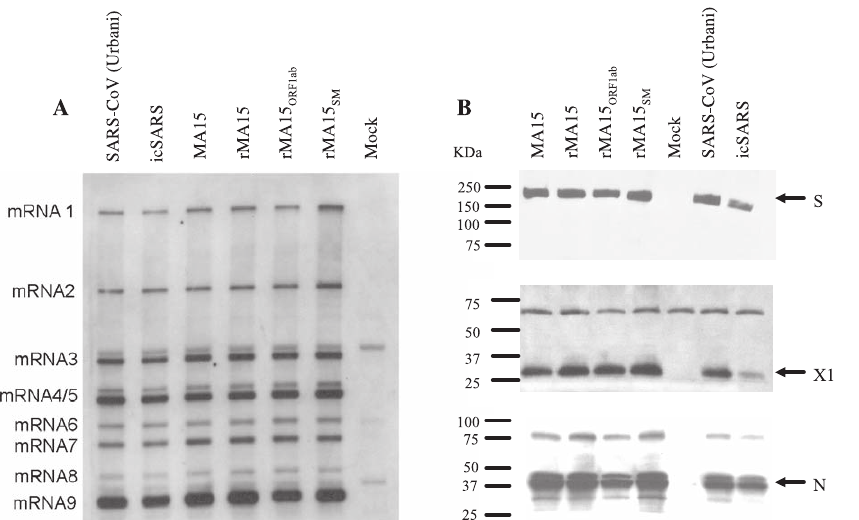
Figure 2. Recombinant SARS-CoVs Demonstrate Normal Processing of vRNAs and Proteins (A) Northern analysis. Intracellular RNA was isolated 10.5 h.p.i. from Vero E6 cells infected with indicated viruses or from mock-infected cells. RNA (0.1 l g) was treated with glyoxal, separated on 1% agarose gel, transferred to a BrightStar-Plus membrane, and probed with an N gene–specific biotinylated oligomer as described in Materials and Methods. (B) Western analysis. Cell lysates were separated on two 7.5% SDS-PAGE gels, transferred to polyvinylidene fluoride and probed with either mouse anti-S antisera (top panel) or probed first with a mouse anti-X1 antisera (sera raised to accessory protein X1 [37]; middle panel), and then stripped and probed again with a mouse anti-N antisera (bottom panel). Each primary antibody was followed by goat anti-mouse HRP-conjugated secondary antibody and visualized by enhanced chemiluminescence.